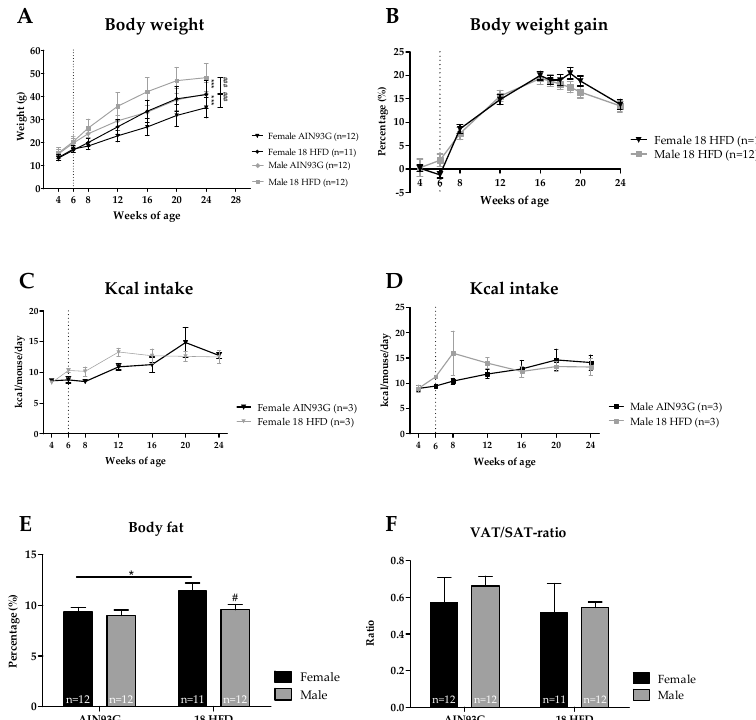
Figure 2. Analysis for body weight, food intake and body fat. ( A ) Absolute body weight in gram. ( B ) Body weight gain as percentage of initial weight of male and female mice fed a HFD after adjustment of the regular growth-related gain in the AIN93G control groups. Kcal intake is presented for female mice in ( C ), and for male mice in ( D ). ( E ) percentage of body fat calculated as the sum of perigonadal, mesenteric and inguinal fat pad weight divided by body weight. ( F ) VAT/SAT-ratio indicated by dividing the mesenteric weight by inguinal weight. The start of HFD feeding at 6 weeks of age is indicated as a vertical, dotted line. * p ≤ 0.05 and *** p ≤ 0.001 significant diet effect (HFD versus AIN93G), # p ≤ 0.050, ### p ≤ 0.001 significant sex-specific effect.